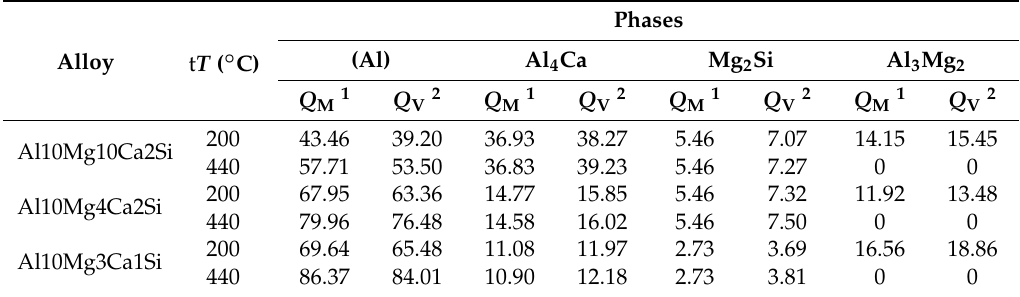
Table 1. Calculated phase fractions for selected alloys of the Al-Ca-Mg-Si system.